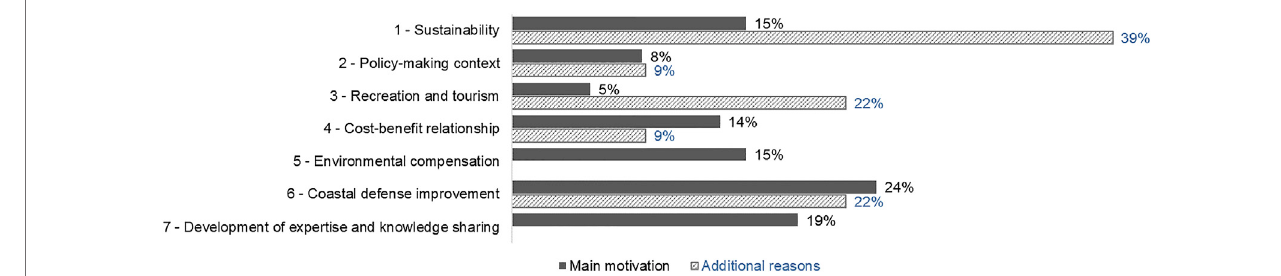
FIGURE 3 | Motivation for the implementation of NbS projects per category in terms of percentage.